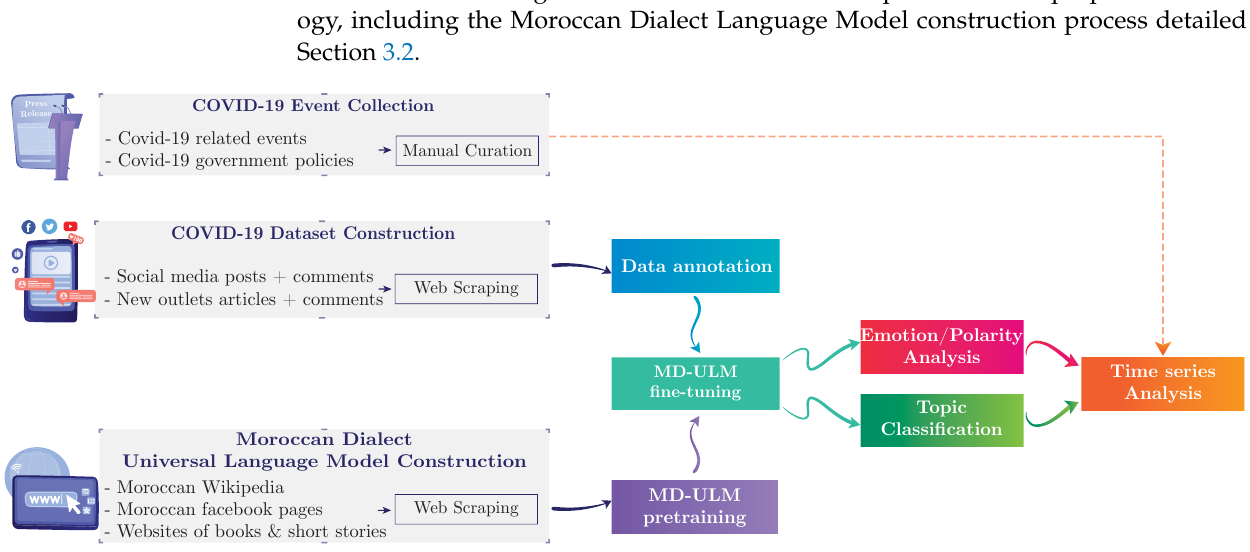
Figure 1. General methodology for COVID-19 Real-Time Infoveillance in